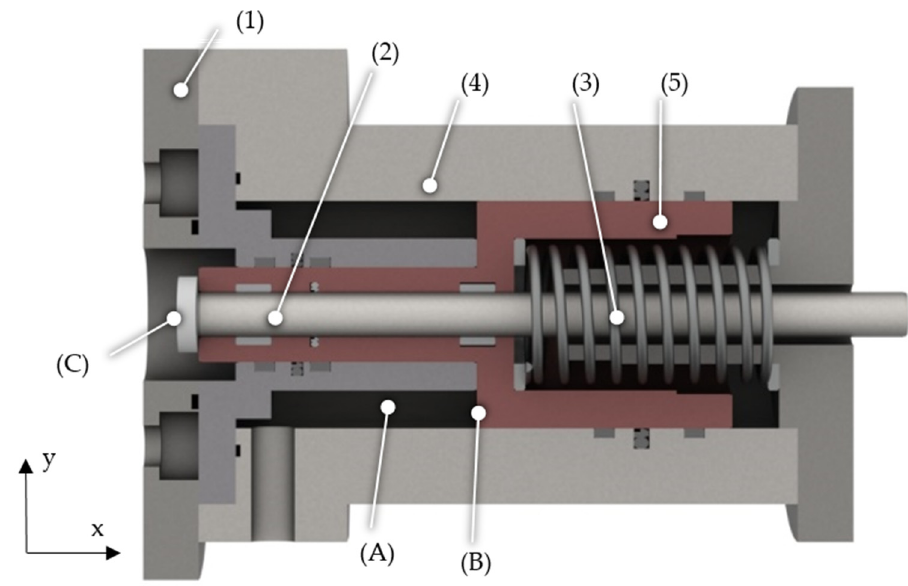
Figure 14. A sectional view of the hydraulic relief system with marked areas ( A – C ). Similar to the magnetic relief system, the hydraulic relief system is placed between the main actuator and the valve. The centering springs are removed from the pilot chambers and incorporated into the relief system. The design consists of a valve adapter (1), a shaft as a mechanical connector (2), a centering spring (3), a housing (4), and a return cylinder (5), which, together with the housing, forms the relief chamber (A). When the relief chamber is pressurized, a force acts on the surface (B) of the cylinder, compressing the spring. This causes the gap between the hard stop (C) and the valve spool to increase. Therefore, the spool is now free to move and is no longer centered by the springs. The relief system needs to be controlled by a hydraulic system, which is shown in Figure 15.